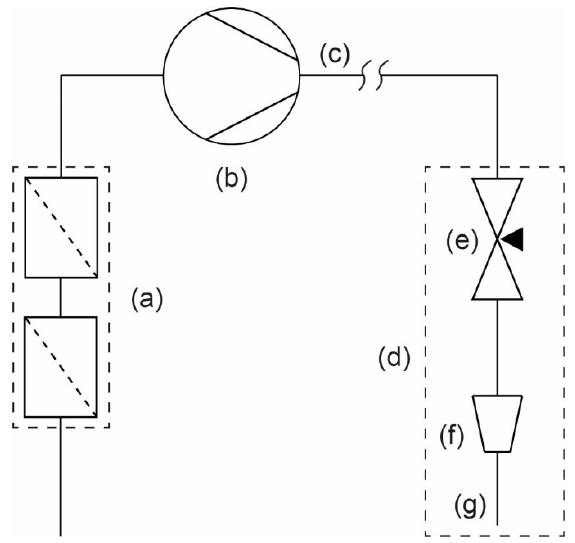
Figure 2. Schematic of the water jet cutting system, used to obtain experimental data on orifice damage with water pre-filters with a mesh size of 10 and 5 µm ( a ), pressure intensifier BFT Servotron 40.37 ( b ), piping system ( c ), cutting head ( d ), switching valve ( e ), orifice ( f ) and nozzle ( g ).